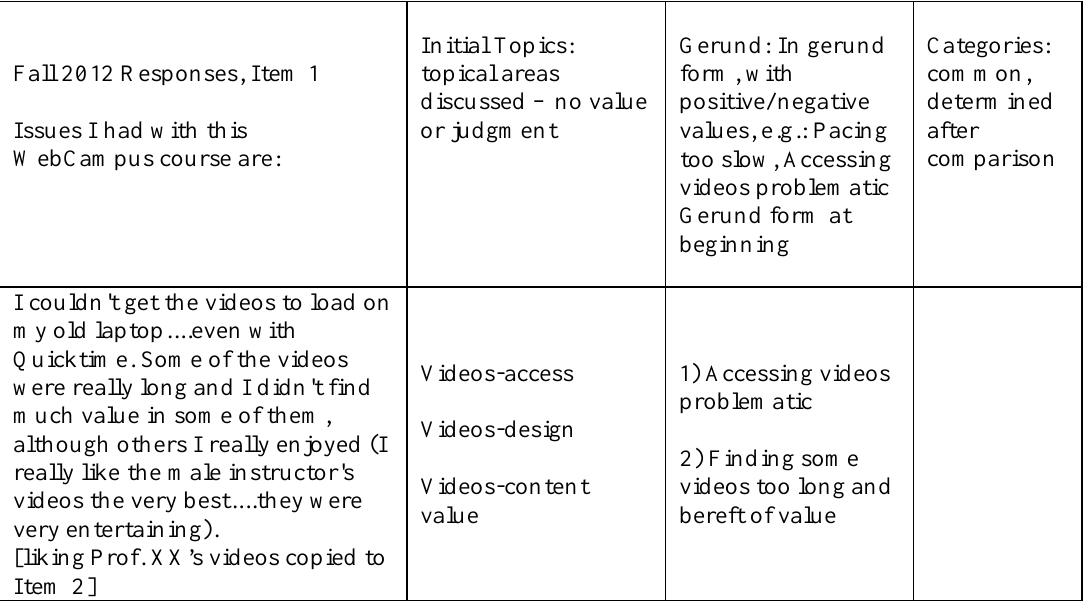
Figure 2. Response table and gerund form of the initial